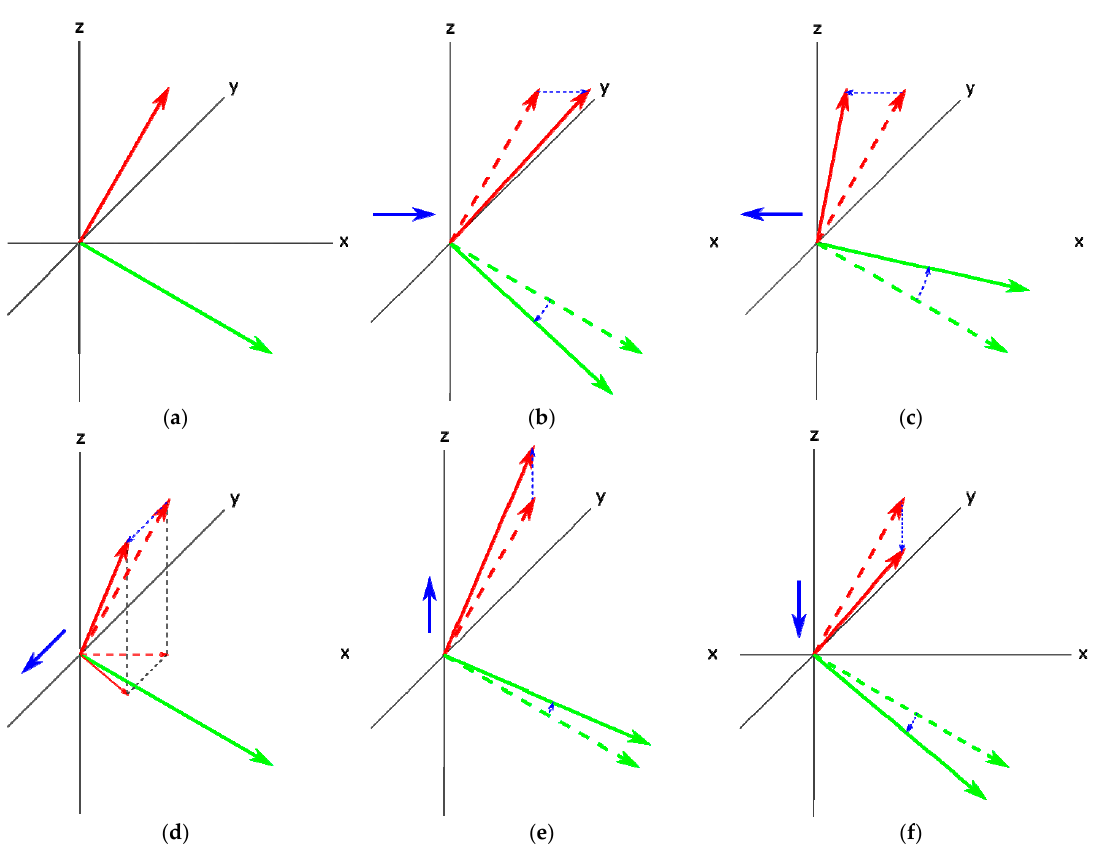
Figure 1. Group velocity ( red ) and wave ( green ) vectors for different wind ( blue ) cases: ( a ) No-wind, ( b ) horizontal downwind, ( c ) horizontal upwind, ( d ) horizontal perpendicular wind, ( e ) vertical upward wind, and ( f ) vertical downward wind. In figures ( b – f ), dashed lines show the no-wind case.